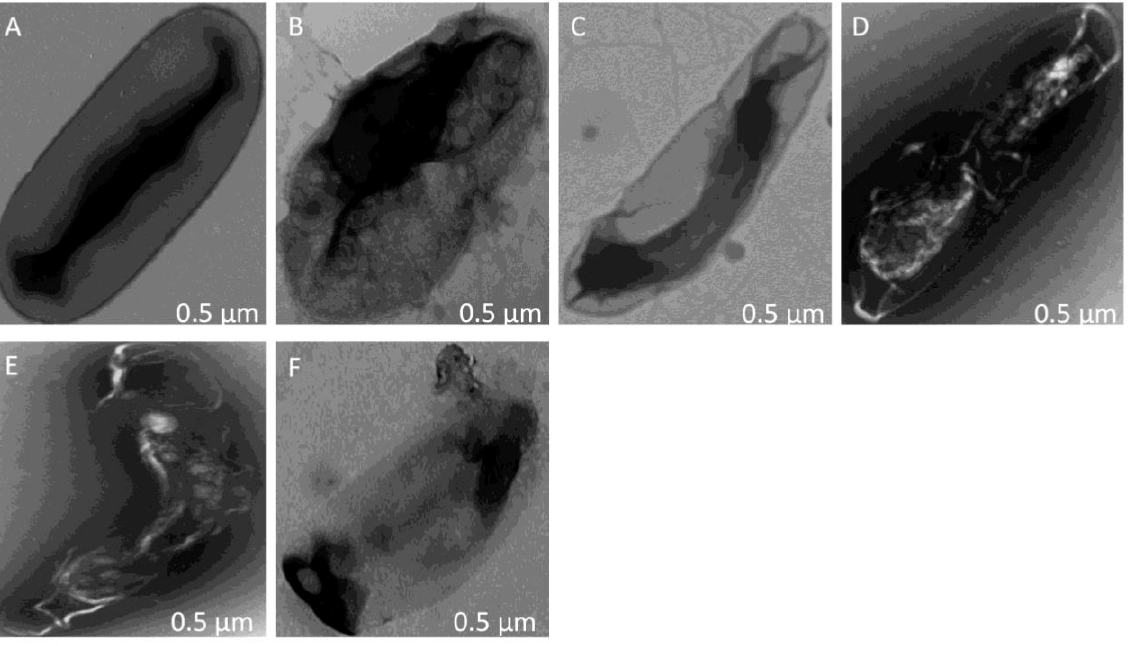
Figure 7. Ultrastructural effect of 50 µg/mL concentration of difficidin, bacillaene and macrolactin, of B. amyloliquefaciens DSBA-11 and mixture of difficidin, bacillyene, macrolactin on R. pseudosolanacearum cells after 14 h determined by TEM. ( A ) an untreated R. solanacearum cell ( B ) R. pseudosolanacearum treated with macrolactin ( C ) R. pseudosolanacearum treated with difficidin ( D ) R. pseudosolanacearum treated with bacillaene ( E ) R. pseudosolanacearum treated with Parent B. amyloliquefaciens DSBA-11 ( F ) R. pseudosolanacearum treated with a mixture of bacillaene, macrolactin and difficidin. Bars: 0.5 µ